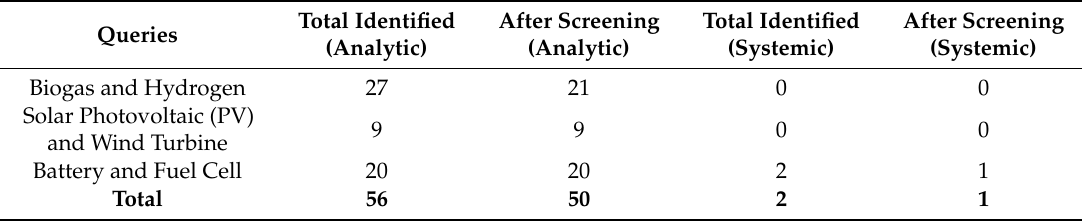
Table 2. Systematic literature review